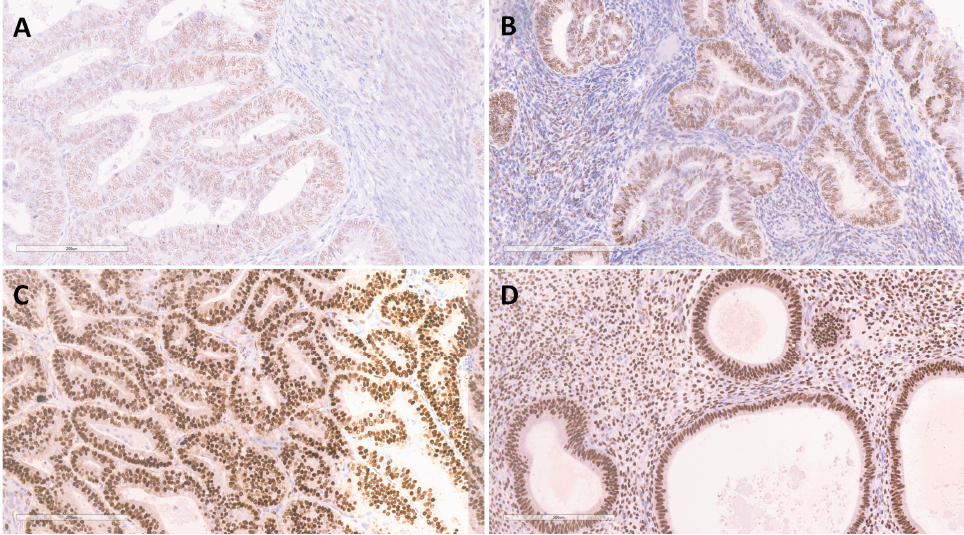
Figure 2. Immunohistochemical staining for ER α in endometrioid endometrial carcinoma showing low expression—1 ( A ), moderate expression—2 ( B ), high expression—3 ( C ), and immunohisto- chemical staining for ER α in benign endometrial hyperplasia showing high expression—3 ( D ). Magnification ×200.